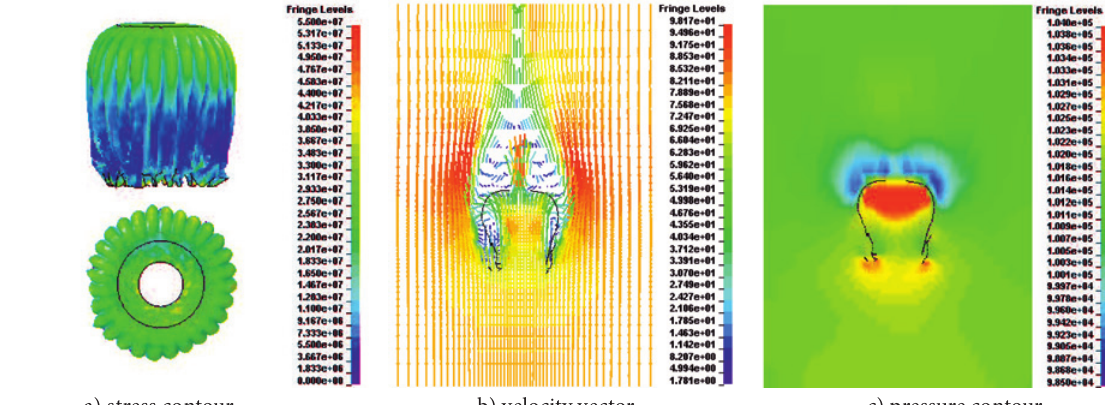
Fig. 6. Structural an d flow fie ld results a t t = 0.156